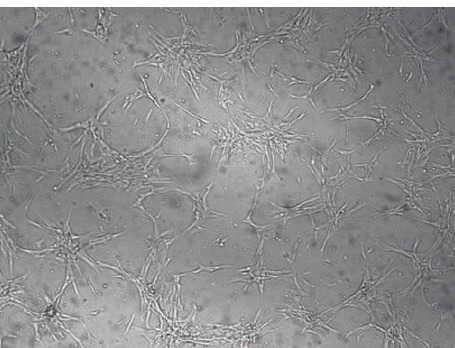
Figure 2: MSCs from the umbilical cord tissue during cell culture. Cell cultures (P0) 10 days after UC fragments removal (24 days of culture), magnification 10x. Cells show a fibroblast-like